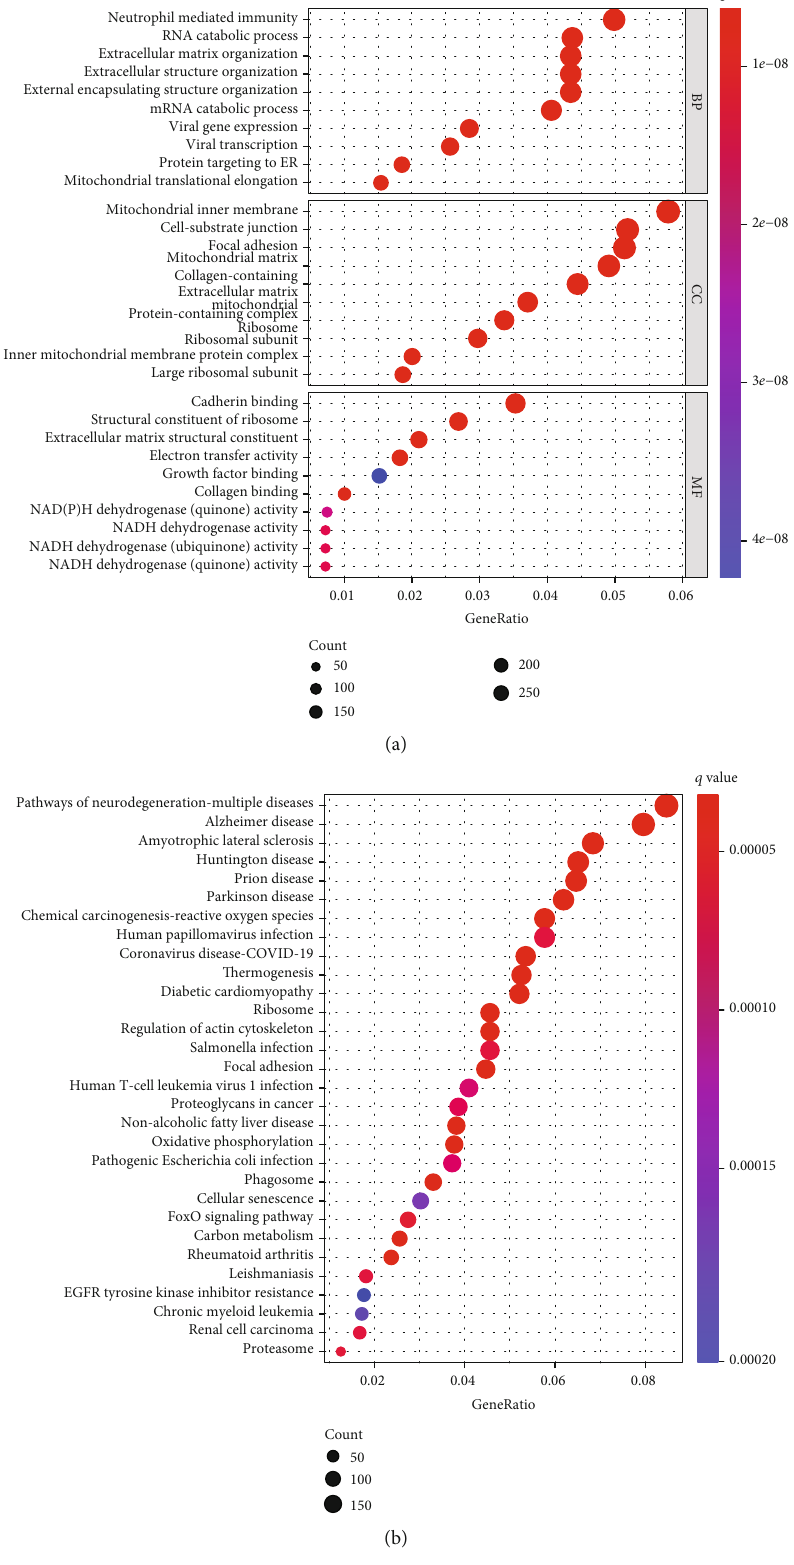
Figure 6: Pathway enrichment investigations of NAV3-related DEGs. (a) The numbers of genes enriched in each GO category. (b) KEGG pathways are analyzed, and the top 30 pathways are